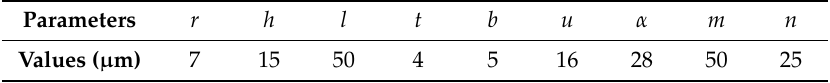
Table 2. The geometric parameters for the microfluidic microsphere-trap